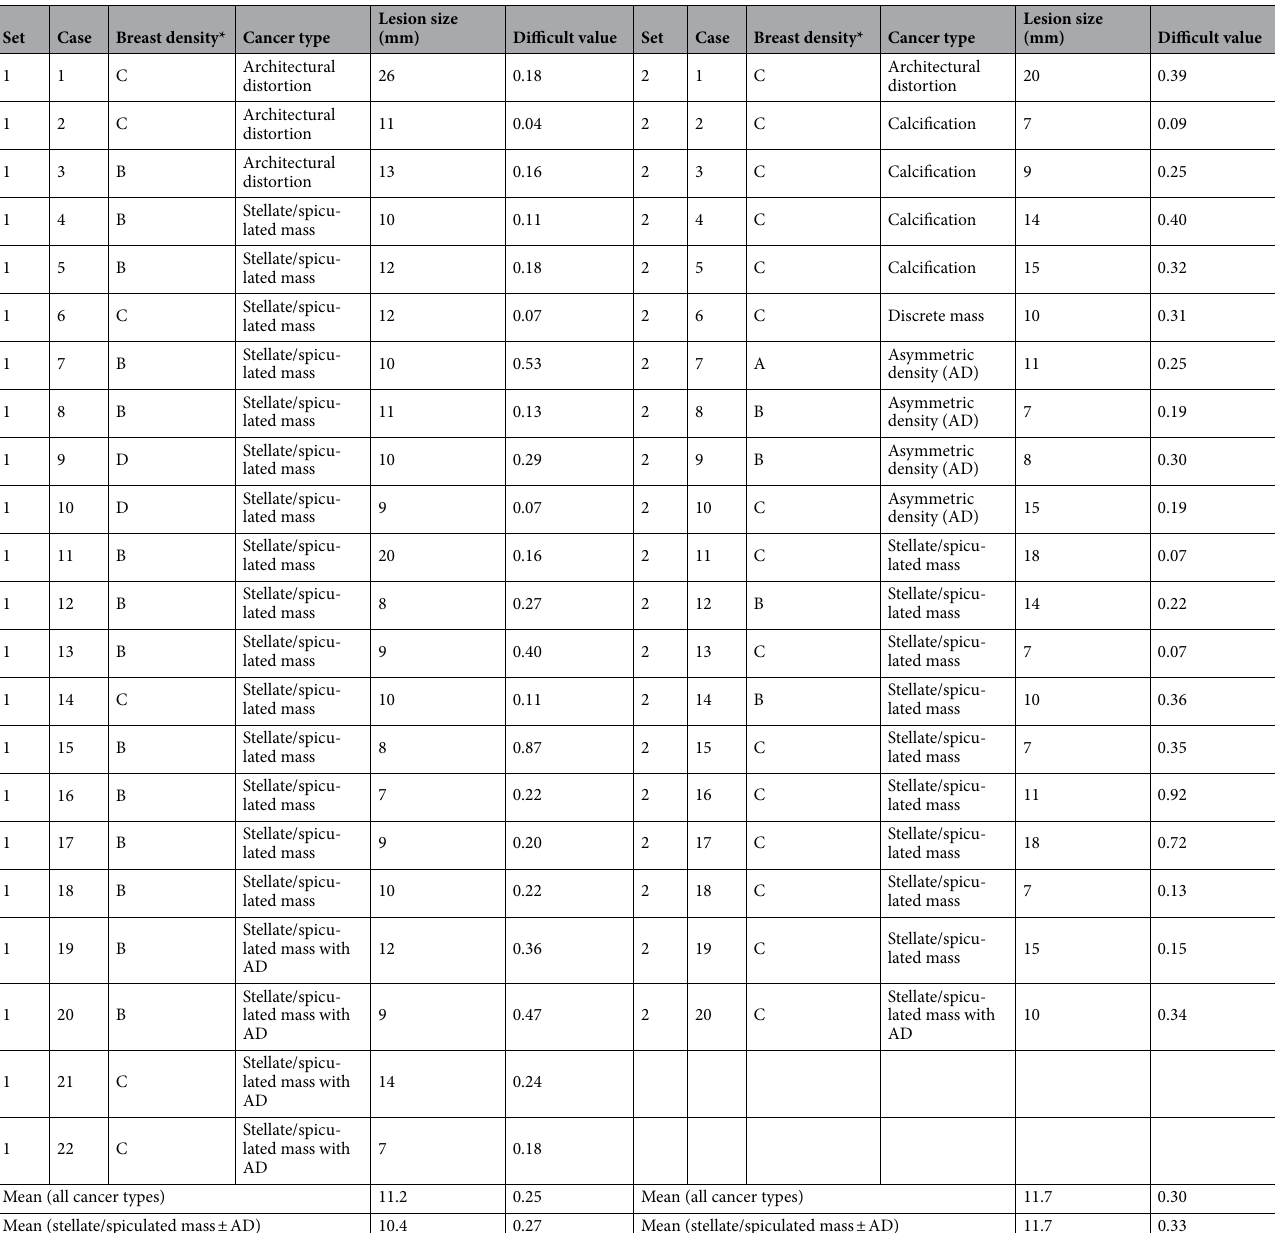
Table 2. Description of cancer cases used in the first session (training set) and the second session (an original BREAST test set). Difficult values were calculated from the BREAST database which were based on the rate of 147 Australian radiologists (45 in set 1 and 102 in set 2) failing to detect cancer locations on the mammograms (the higher values represent the more difficult cases). *A: fibrograndular tissue < 25%, B: fibroglandular